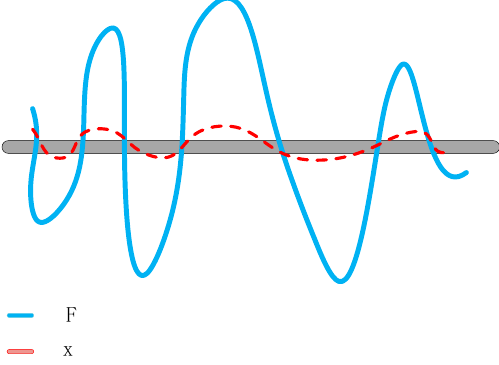
Figure 6. Deep residual network (Resnet) transfers the learning problem from reaching F (blue line) to reaching the direct linear mapping x (red line).